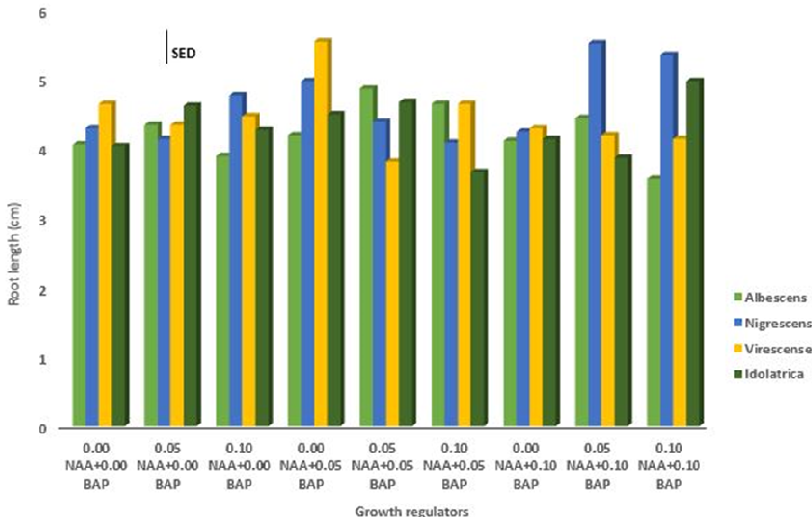
Fig. 1. Interaction effect of growth regulators and type-variety of oil palm on root length at 35 days after culture initiation